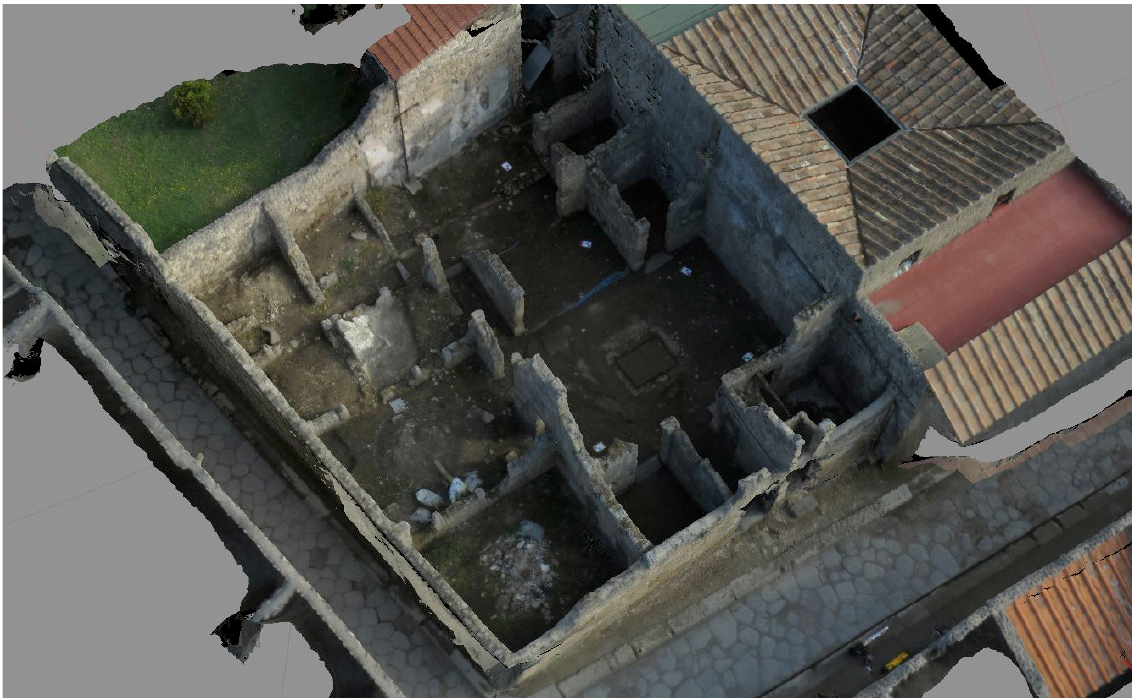
Figure 5. 3D model of Domus of Stallius Eros obtained by drone photogrammetry (top view)